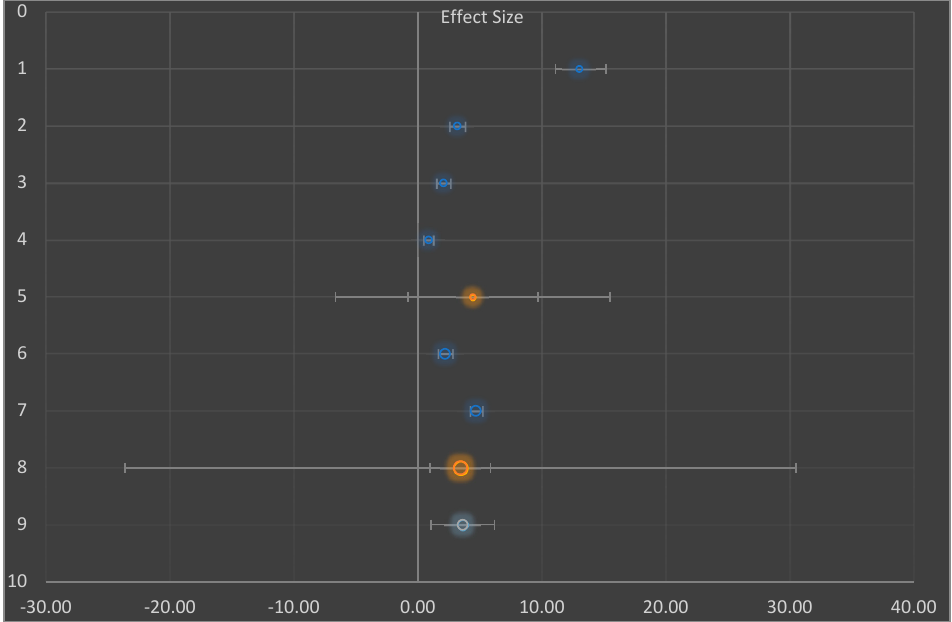
Figure 5. Showing random effect meta-analysis of the mean different in total subgroup analysis for the decrease in blood sugar level (mg/dL).